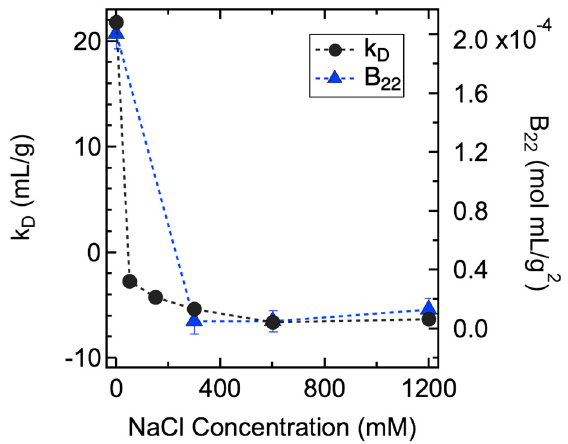
Figure 1. Summary of k D (black circle) and B 22 (blue triangle) values measured at various NaCl concentrations. Error bars represent the standard errors; some errors are smaller than the plotting symbols. In particular, uncertainties in k D were determined as the propagation of standard errors of the coefficients from the linear regression.